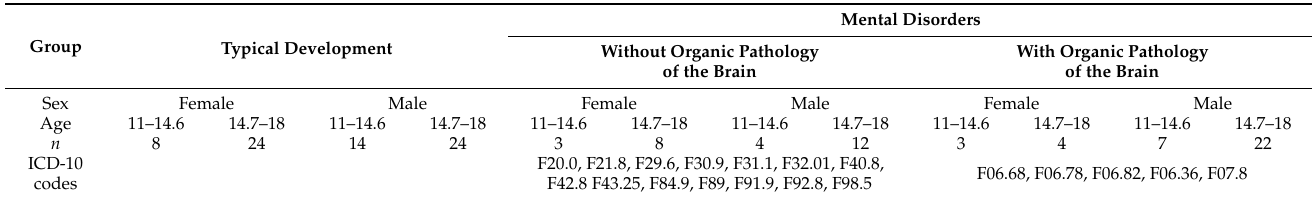
Table 1. Gender and age characteristics of adolescents in the examined